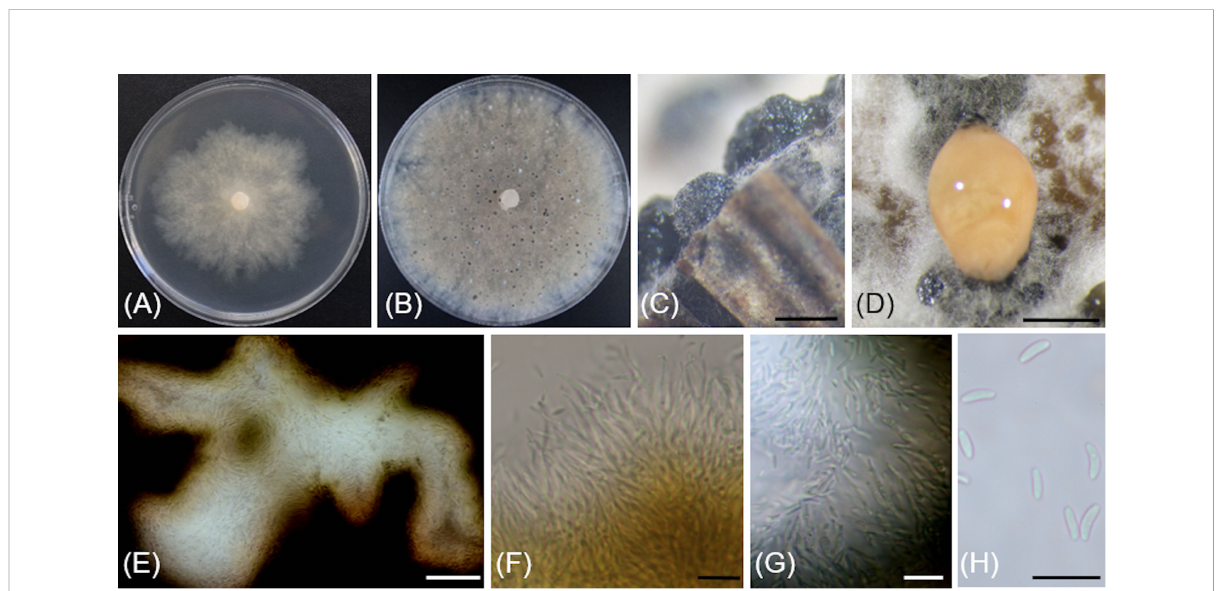
FIGURE 6 Cytospora yakimana (CBS 149297/Bent902). (A) 4-day-old culture on PDA. (B) 14 - day-old culture on PDA. (C) Pycnidia produced in vitro on sterile grapevine wood. (D) Pycnidium exudating pale luteous to saffron colored mucilage. (E) Locular chamber lined with conidiogenous cells. (F) Straight and branched conidiogenous cells. (G) Conidiogenous cells and conidia. (H) Conidia. Scale bars: 1 mm (C, D) ; 50 µm (E) ; 10 µm (F – H)